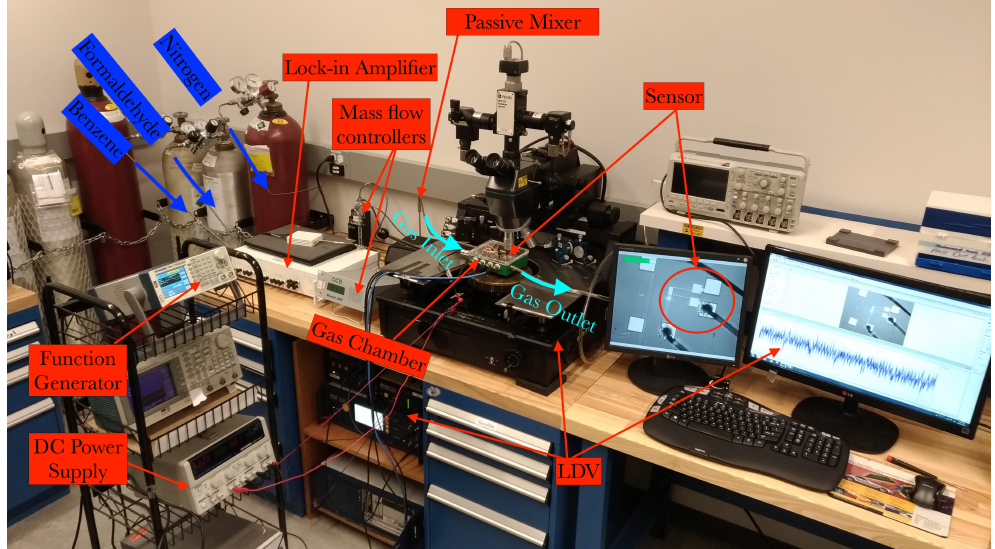
Figure 12. The experimental setup of gas